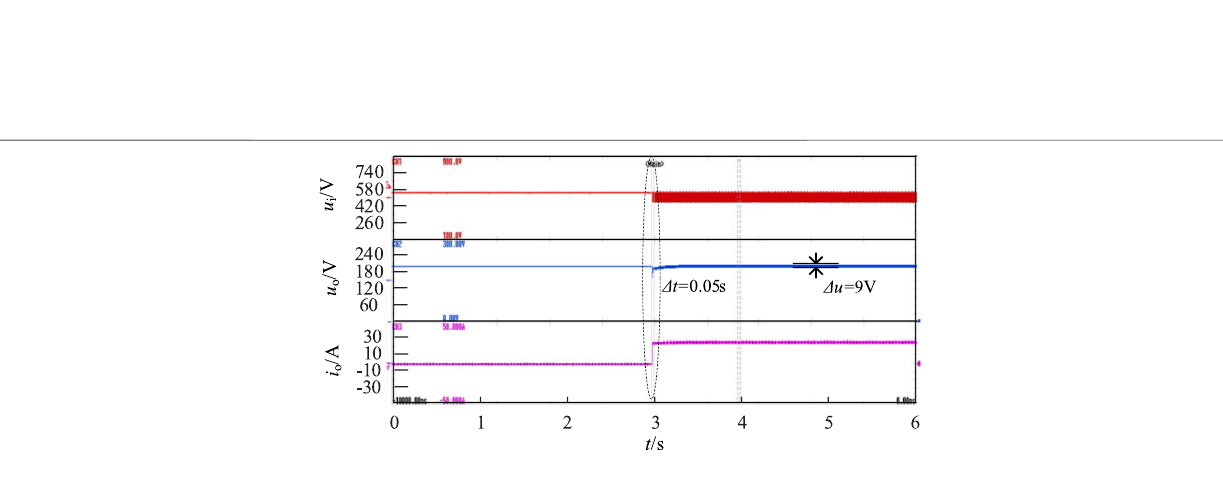
FIGURE 13 | Experimental waveforms for the proposed control